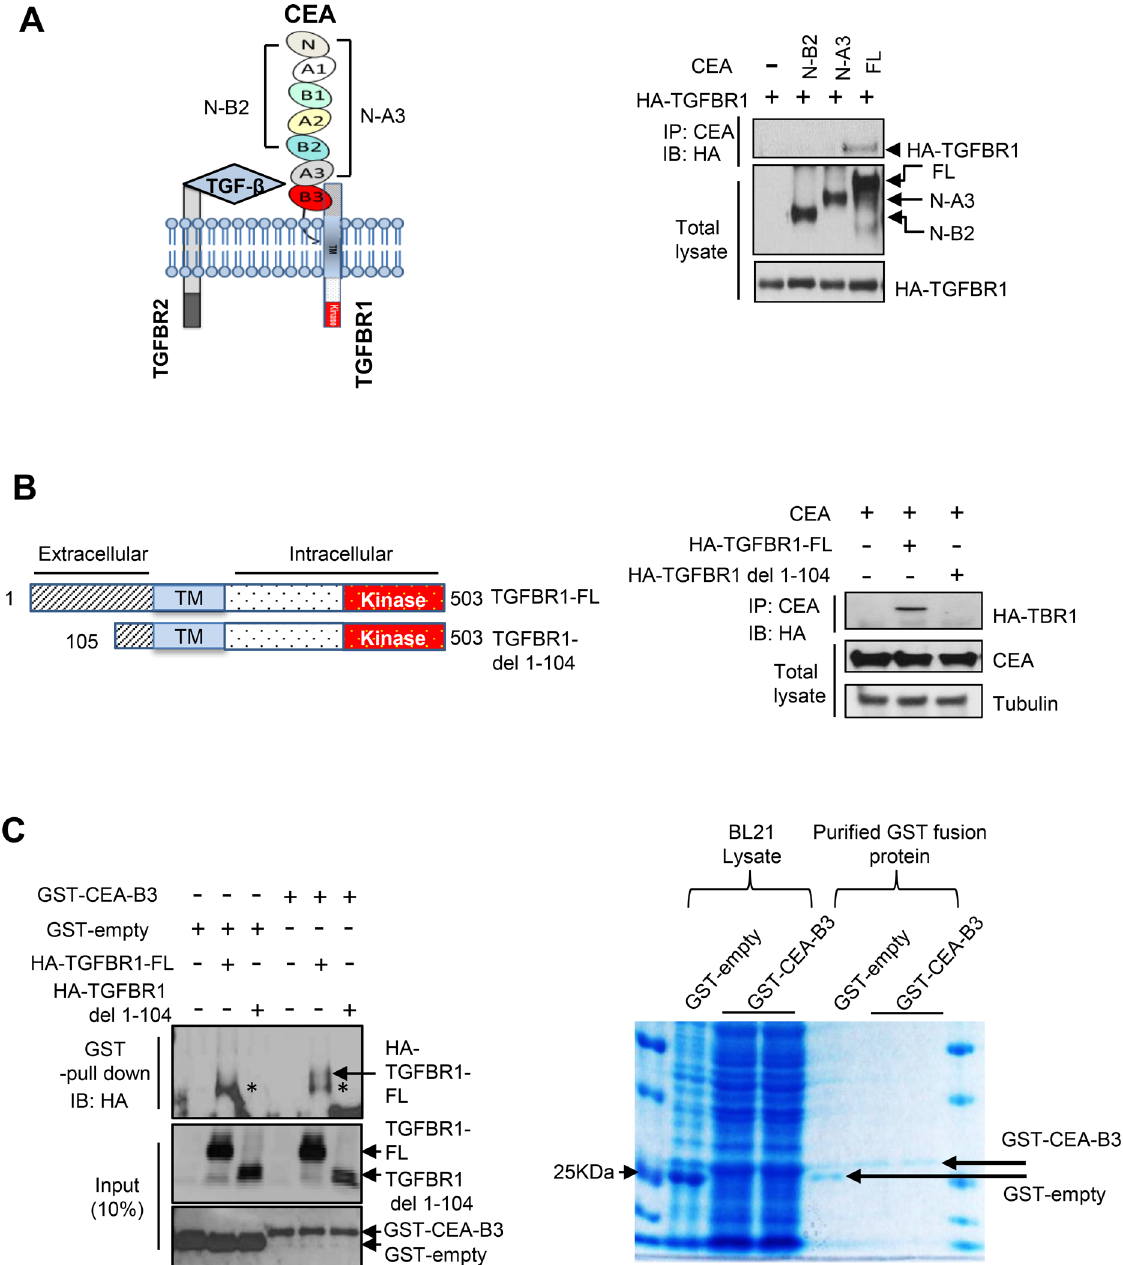
Fig 4. CEA interacts with the TGF- β pathway. (A) The CEA B3 domain is required for the interaction of CEA with TGFBR1. HCT116 cells were co- transfected with the generated mutants. Cell lysates were immunoprecipitated with the CEA antibody and were immunoblotted with the indicated antibodies. (B) CEA interacts with the extracellular domain of TGFBR1 (amino acid 1 – 104). The generated TGFBR1 mutant plasmids were co-transfected into the cell lines and immunoprecipitation was carried out with CEA antibodies, followed by immunoblotting. (C) The CEA B3 domain interacts directly with TGFBR1. The CEA B3 domain GST fusion protein was produced bacterially. HA-TGFBR1-FL or HA-TGFBR1-1-104 deletion plasmids were transfected in 293T cells. Purified TGFBR1-FL (full length) or HA-TGFBR1- del-1-104 was incubated with GST-empty or GST-CEA-B3 proteins. The binding of TGFBR1 to CEA-B3 domain was detected by immunoblotting using anti-HA antibody. * designates non-specific bands. Purified GST fashion proteins were detected by Coomassie blue staining. Glutathione Resin GST Fusion Protein Purification Kit (GenScript, Cat. L00206) was used for purification of GST-CEA-B3 domain fusion protein.